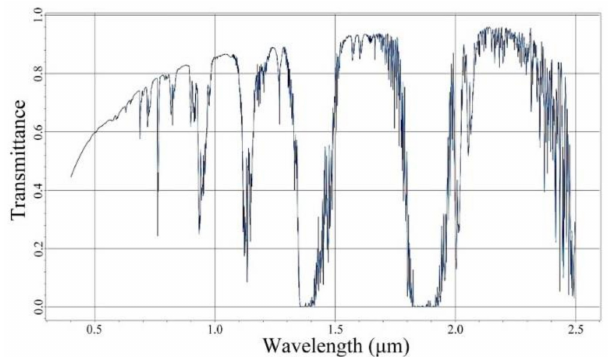
Figure 4. Atmospheric transmittance curve (atmospheric